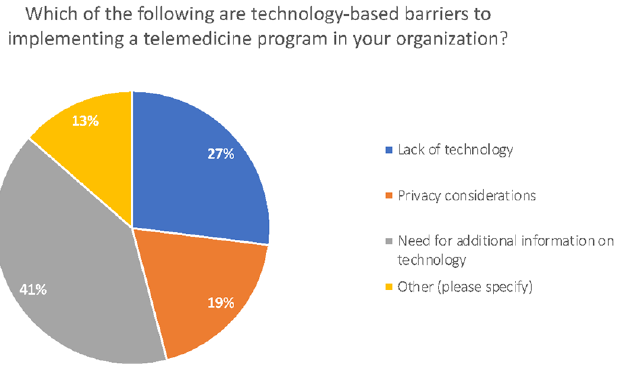
Figure 3. Technology-based barriers to implement telemedicine.